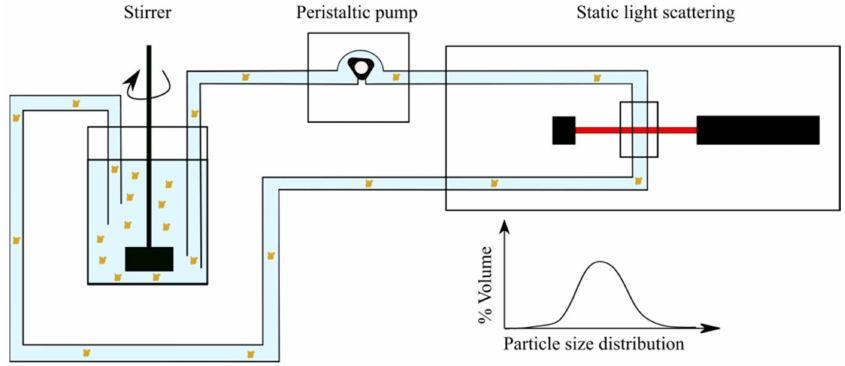
Figure 2. Sketch of the experimental